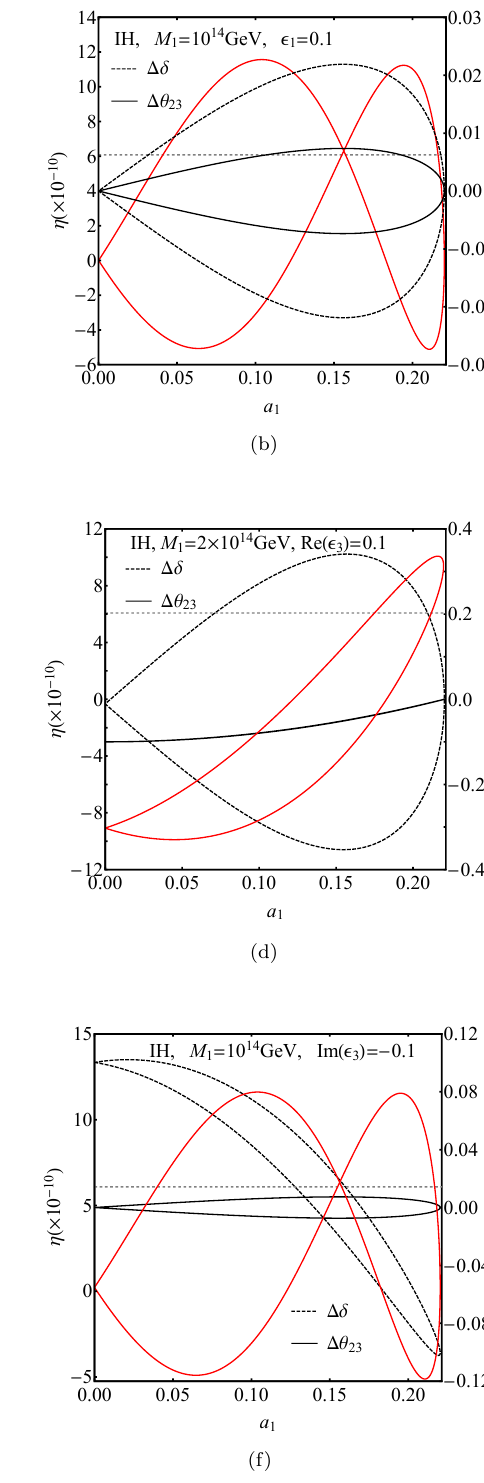
(as functions of a ) from the parameter choices shown in 23 1